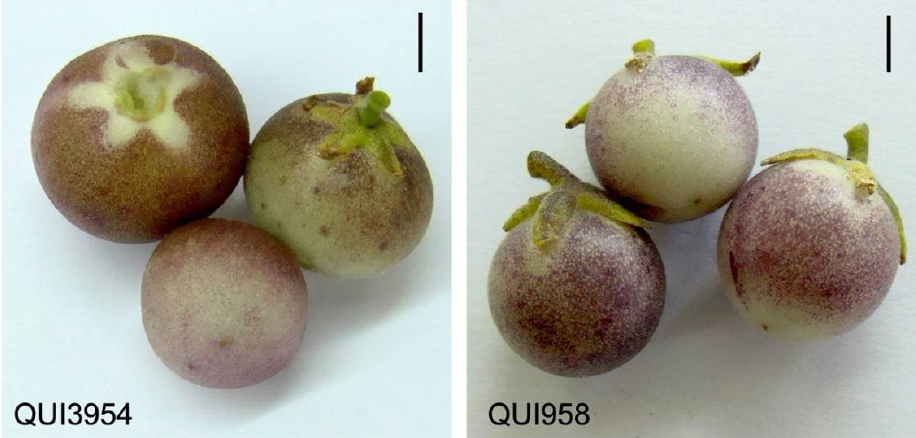
Figure 1. Representative ripe fruit of the Solanum peruvianum accessions QUI3954 and QUI958 of the germplasm collection of the Genetic Resource Unit (GRU) at Agricultural Research Institute (INIA-Quilamapu), Chillán, Chile. The bar in each panel represents 1 cm.